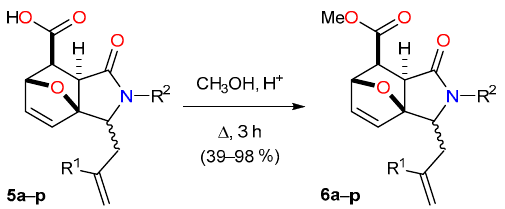
Table 1. Influence of solvents and temperature on the yields and ratios of trans - 5A / cis - 5B isomers of 3-allyl-1-oxo-3a,6-epoxyisoindole-7-carboxylic acids ( 5 ).